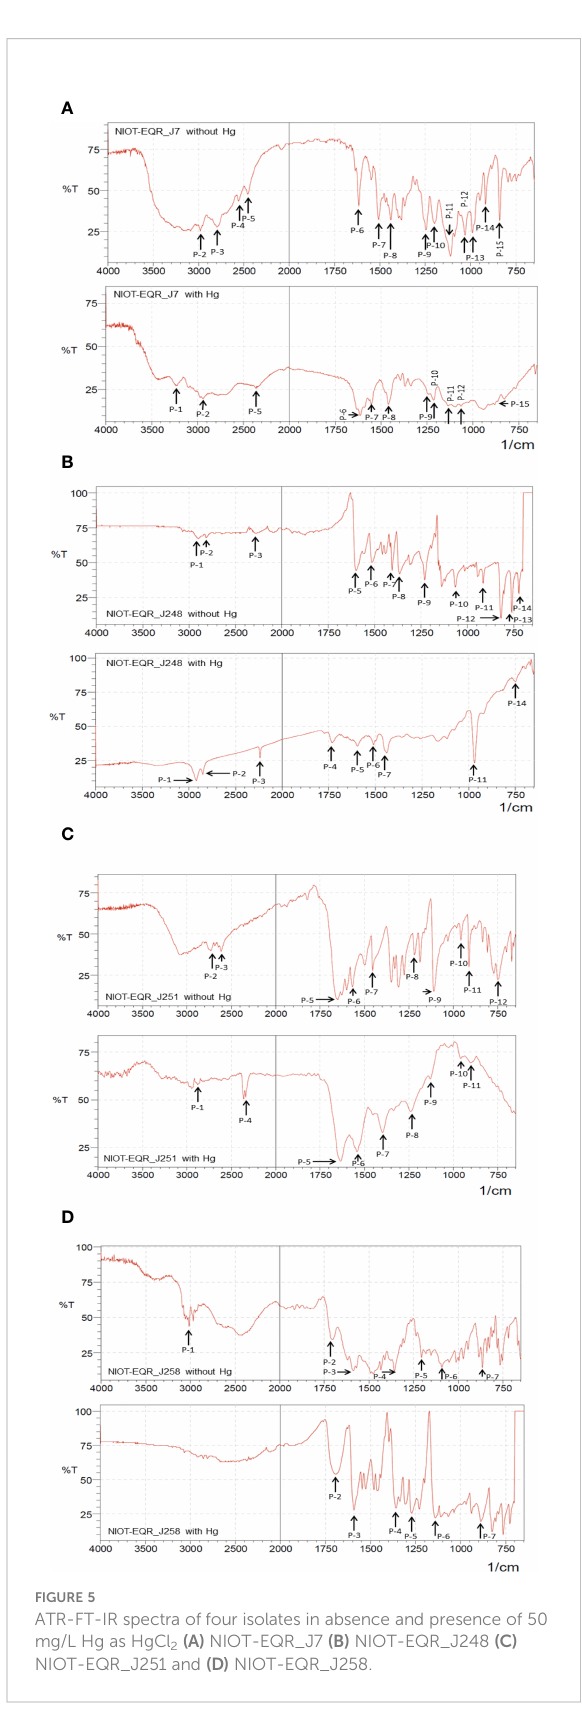
FIGURE 5 ATR-FT-IR spectra of four isolates in absence and presence of